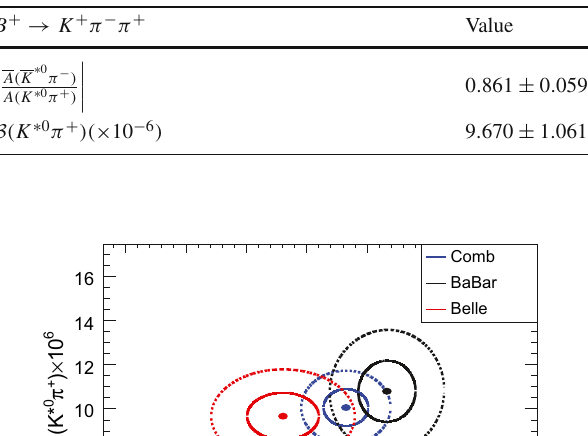
(cid:17) (cid:17) (cid:17) ( K ∗ 0 π − ) (cid:17) vs. (cid:17) A A ( K ∗ 0 π + )